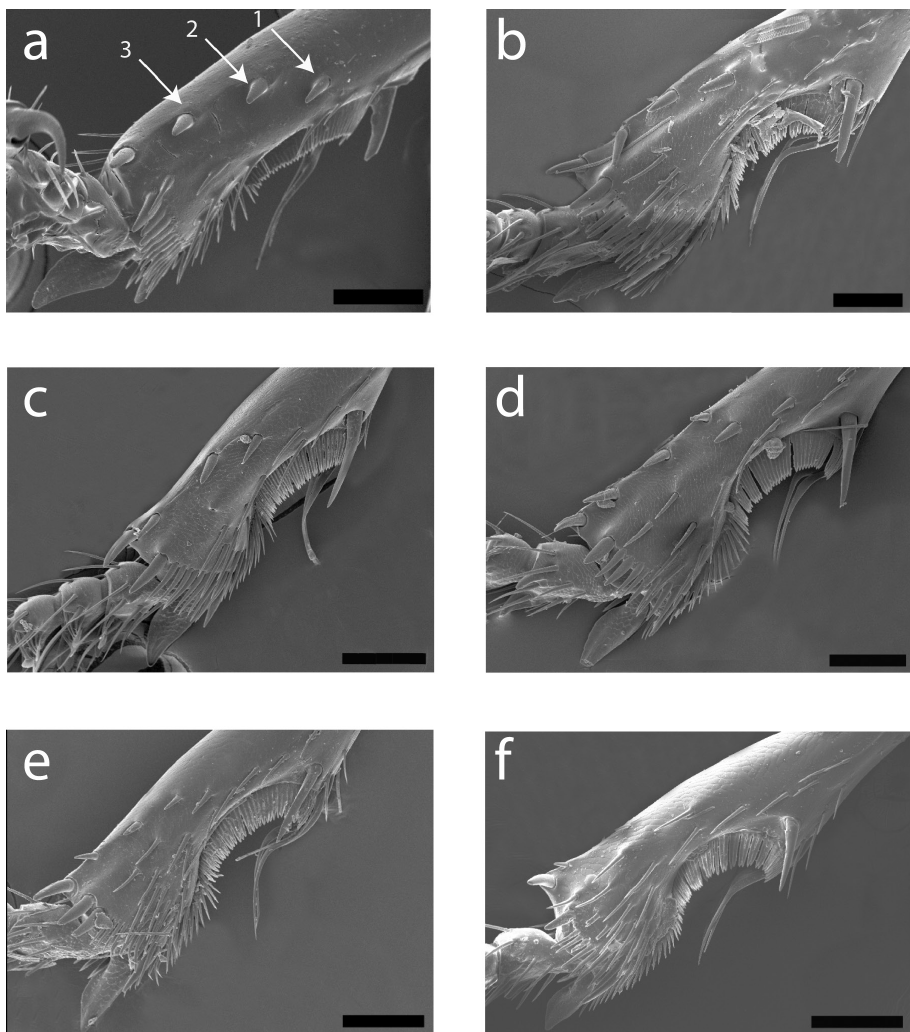
Figure 10. Scanning electron micrographs of left protibia for: a Cratocerus sinesetosus b Cratocerus mul- tisetosus c Cratocerus tanyae d Cratocerus indupalmensis e Cratocerus kavanaughi f Cratocerus culpepperi . Arrows point to distinct, stout spines referred to in text. Scale bars = 100